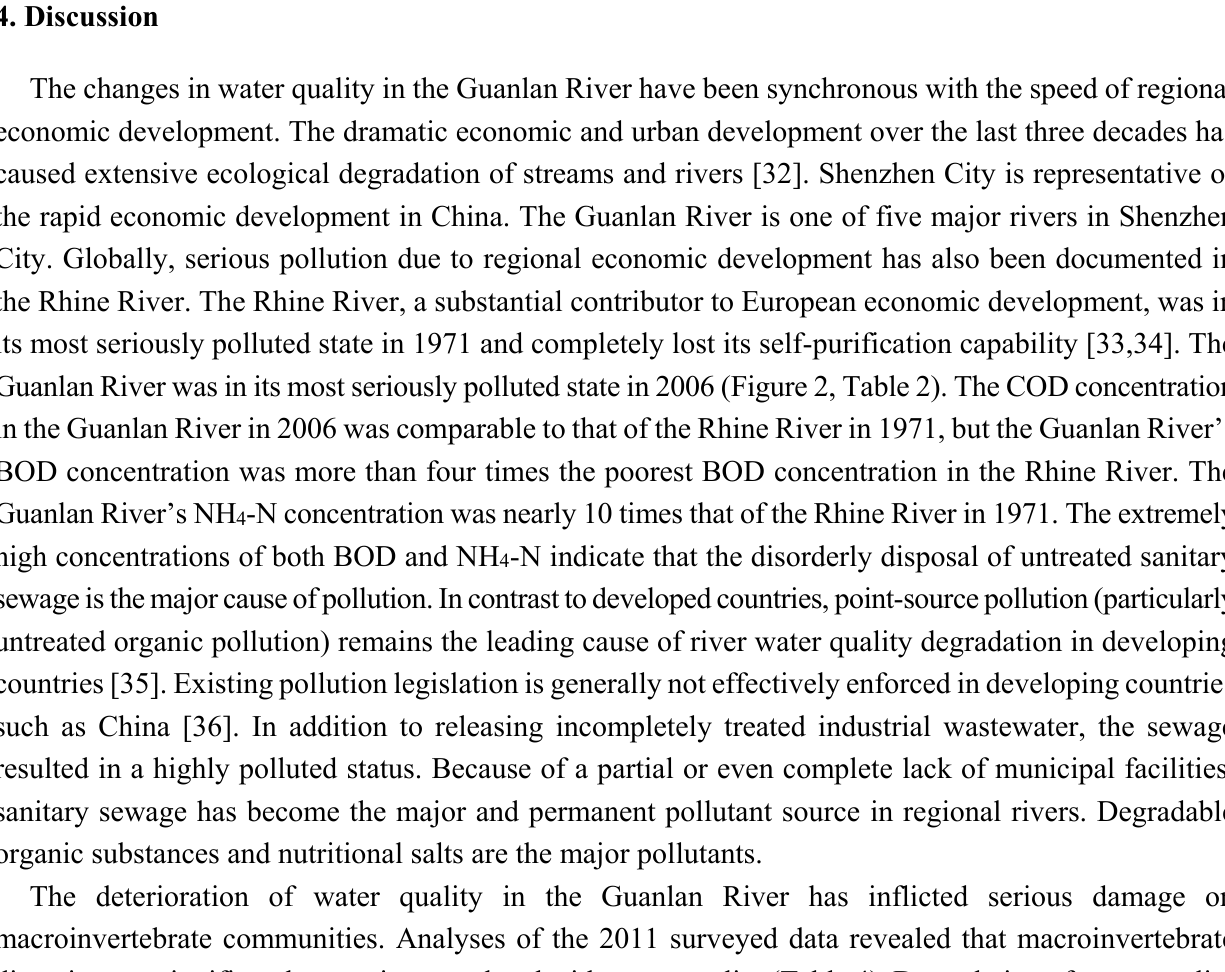
Figure 6. Spatial distributions of macroinvertebrates in the Guanlan River after five years of comprehensive remediation. Data are provided as a 2011 average, with SE error bars ( n = 6). ( a ) Taxa richness; ( b ) Shannon-Wiener diversity index; ( c ) Density; ( d ) Wet